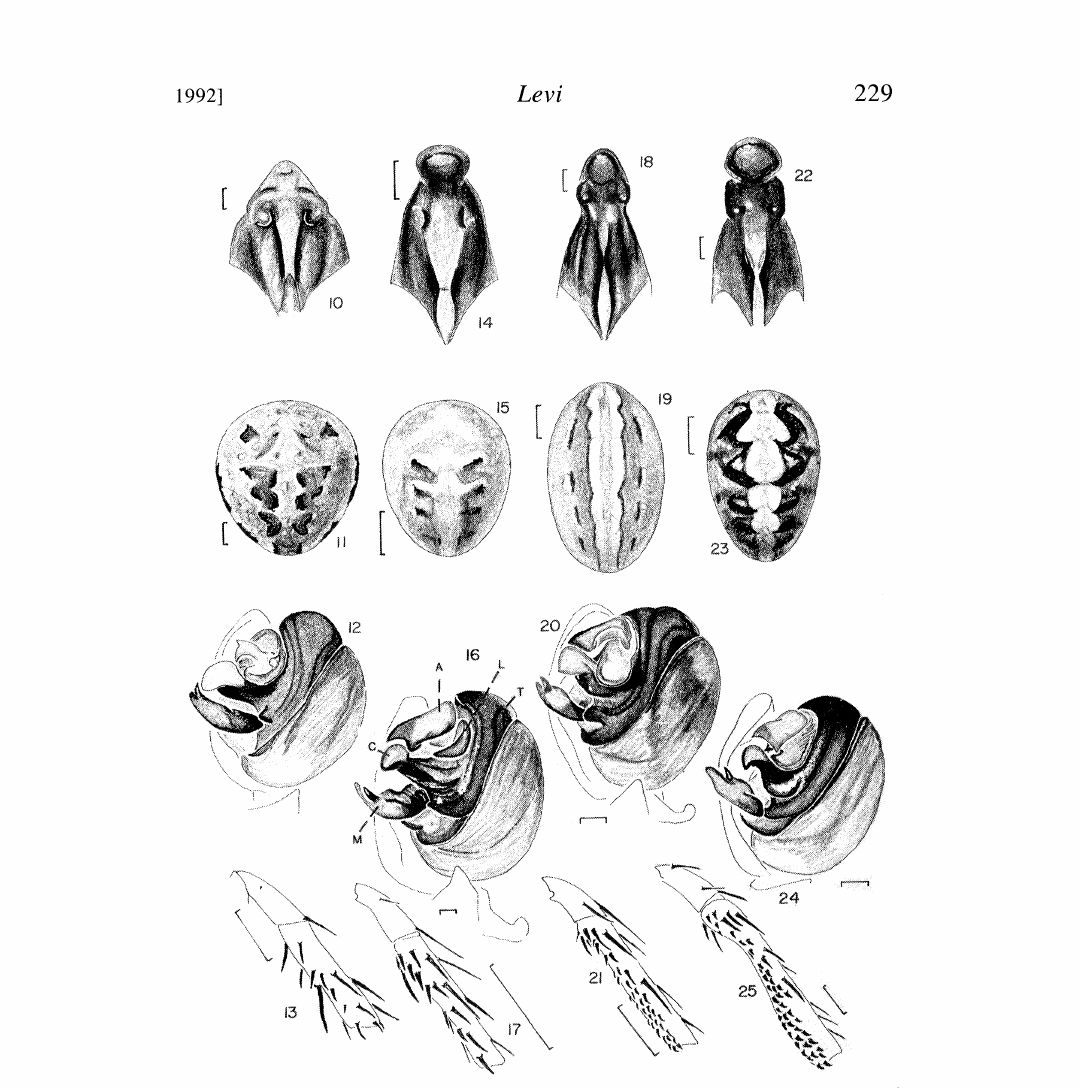
Figures 10-13, Neoscona nautica. 10, epigynum, posterior, ll, abdomen of female. 12, male left palpus, lateral. 13, male left second patella and tibia, anterior. Figures 14-17, N. arabesca. 14, epigynum, posterior. 15, abdomen of female. 16, male palpus, lateral. 17, male second patella and tibia, anterior. Figures 18-21, N. moreli. 18, epigynum, posterior. 19, abdomen of female. 20, male palpus, lateral. 21, male second patella and tibia, anterior. Figures 22-25, N. oaxacensis. 22, epigy- num, posterior. 23, abdomen of female. 24, male palpus, lateral. 25, male second patella and tibia, anterior. Scale lines mm; genitalia 0.1. Abbreviations. A, terminal apophysis. C, median apophysis. L, embolus lamella. M, median apophysis. T,